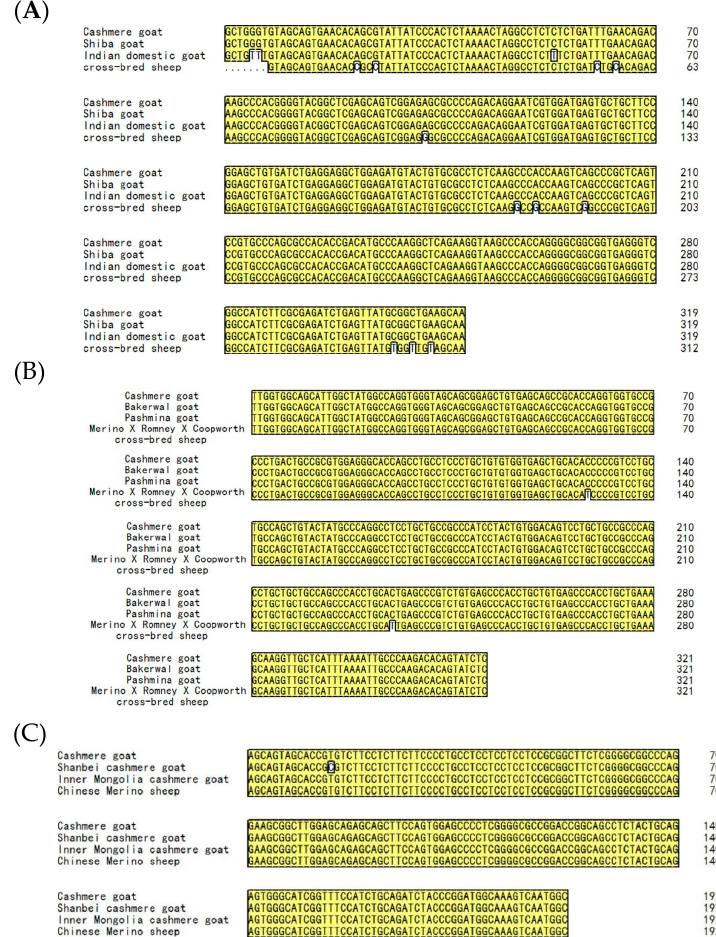
Figure 3. Nucleotide sequence alignment of genes IGF-1 ( A ), FGF5 ( B ), and KAP 1.4 ( C ) in North- western Tibetan cashmere goats along with that of other goat and sheep breeds. “Cashmere goat” stands for Northwestern Tibetan cashmere goat.